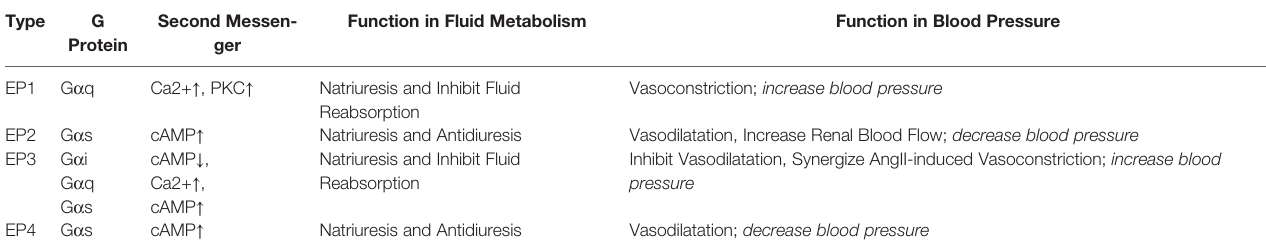
TABLE 3 | Roles of EP receptors in the regulation of fl uid balance and blood pressure.